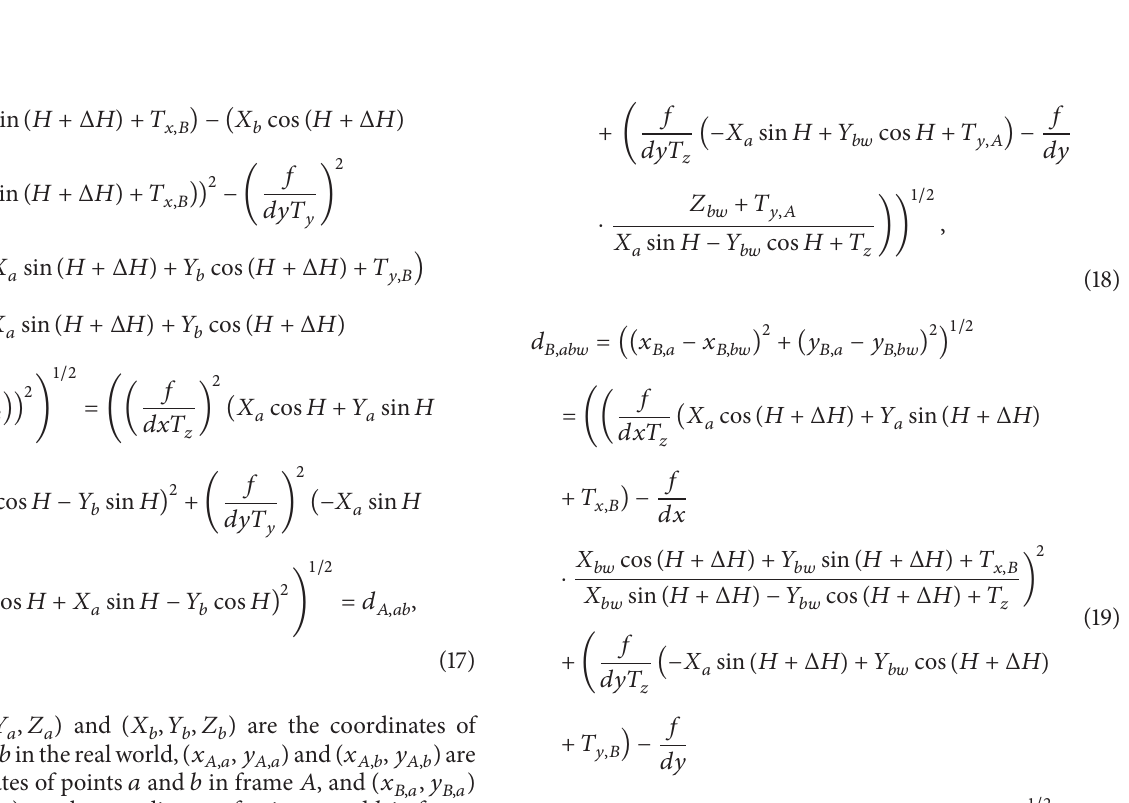
Figure 5: The connect lines on the ceiling. (a) The connect lines on the original ceiling. (b) The connect lines on the ceiling after rotation and